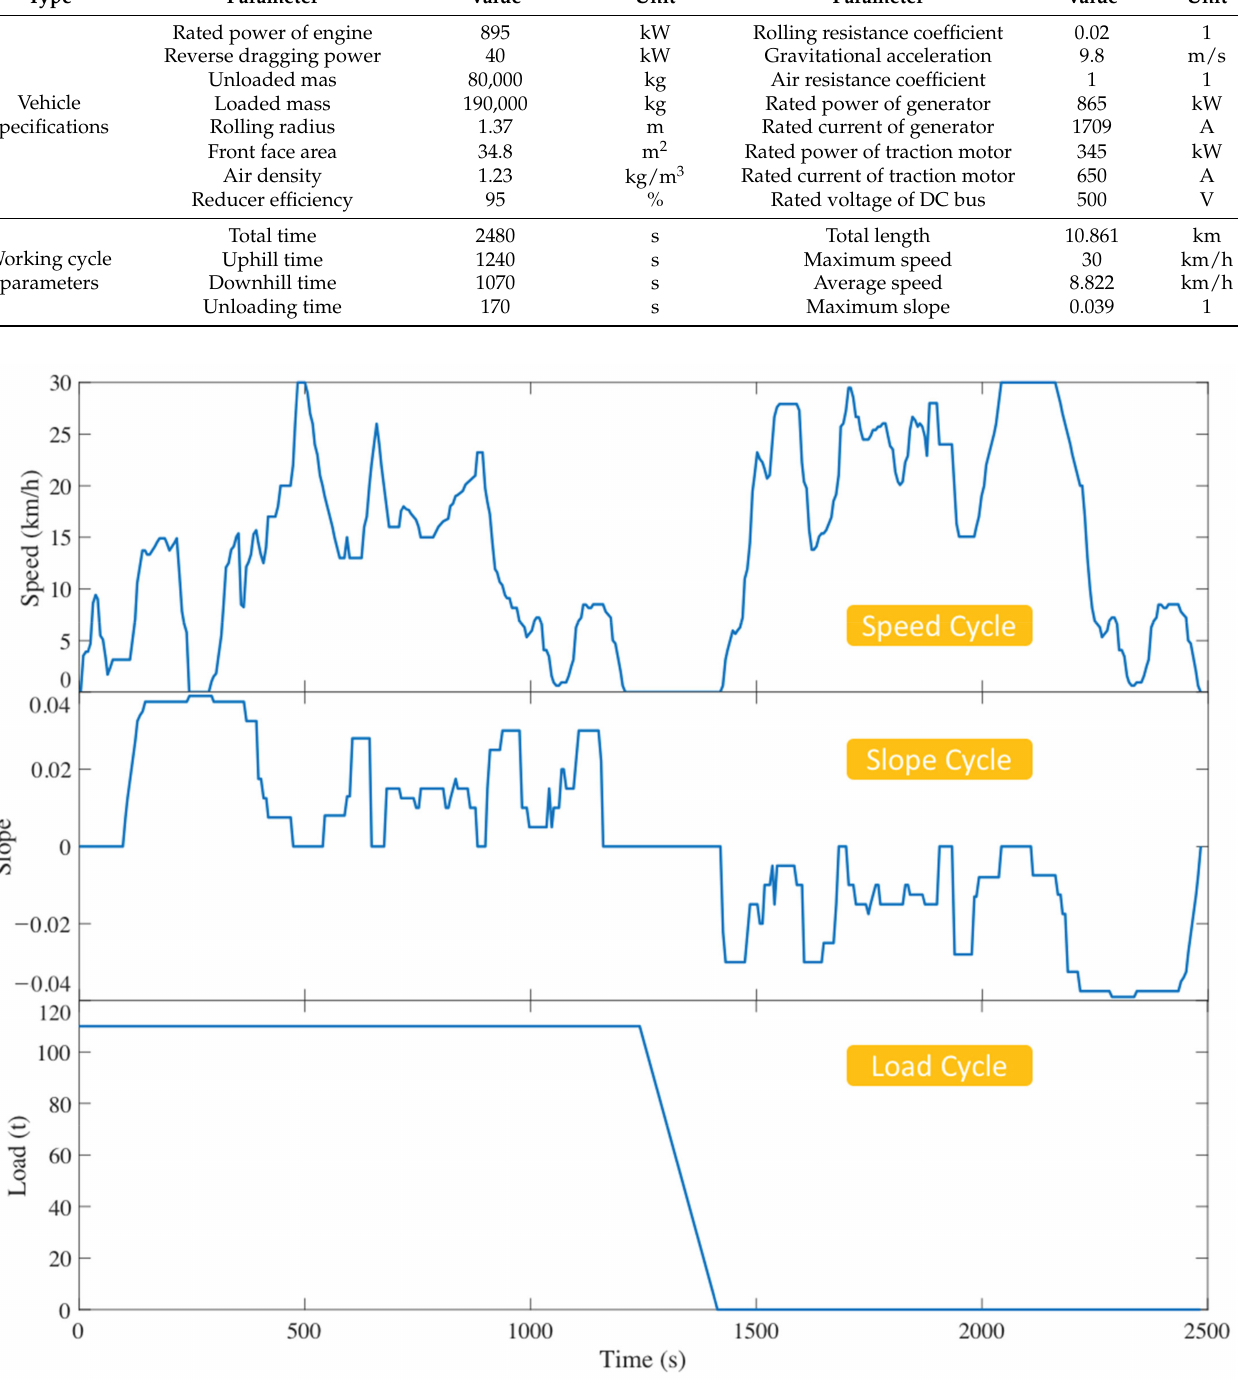
Figure 9. Actual working cycle of the target mining